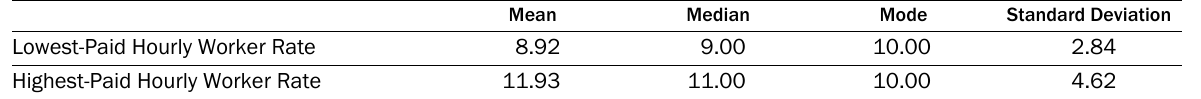
Table 3. Mean, Median, and Mode of Lowest- and Highest-Paid Workers, Hourly Rate; N =124 for Lowest Paid; N =118 for Highest Paid (All in